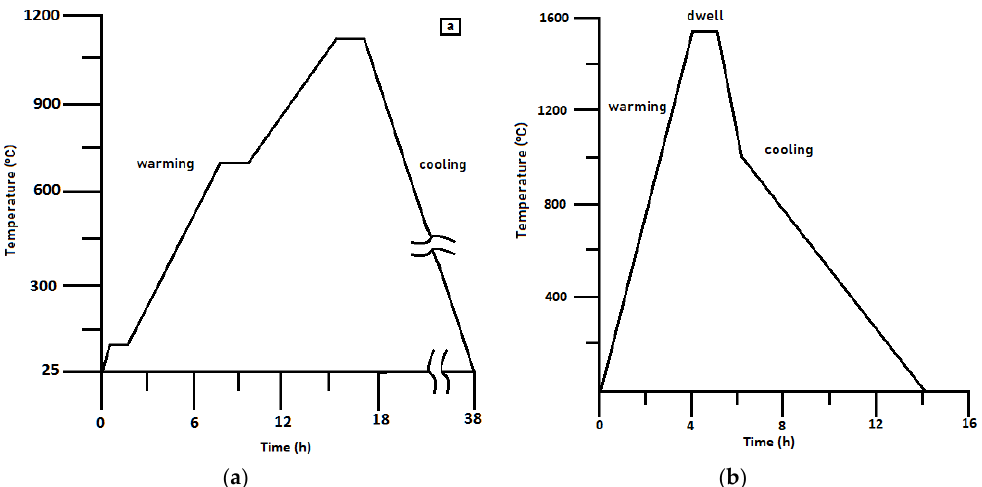
Figure 4. Thermal treatment ( a ) debinding, ( b ) mode of high ‐ temperature sintering of ceramic samples. Selection of Modes for Printing